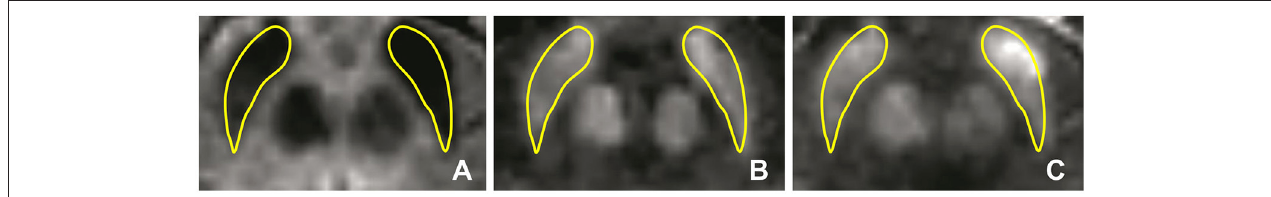
FIGURE 4 | Iron-sensitive imaging of the substantia nigra. The regions of interest for the substantia nigra were defined bilaterally for iron-sensitive imaging as the hypointense band between the red nucleus and cerebral peduncle in the T2 * -weighted images (A) and were then used to sample the R2 * maps (B) and susceptibility (C) maps, seen here for a 51-year-old man with PD.